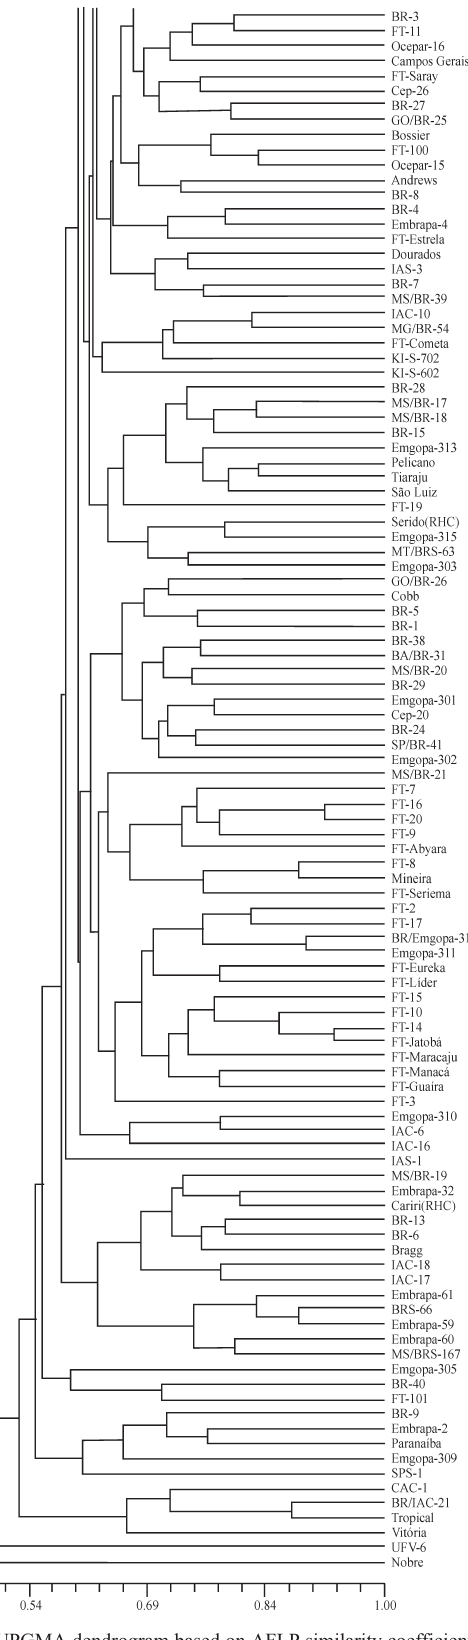
Figure 4c - UPGMA dendrogram based on AFLP similarity coefficients of 317 soybean cultivars